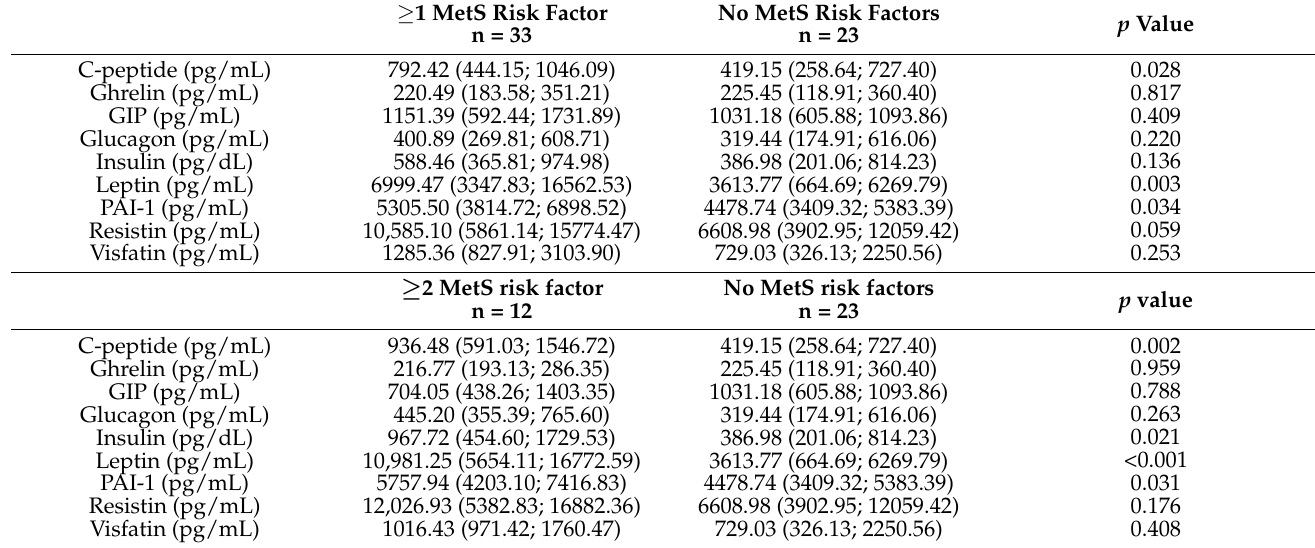
Table 5. Characteristic of acute lymphoblastic leukemia survivors according to number of metabolic risk (MetS)